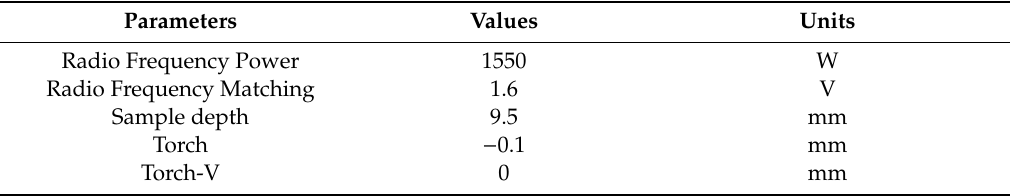
Table 2. Work specification resume for ICP-MS Agilent 7700 × and measurement